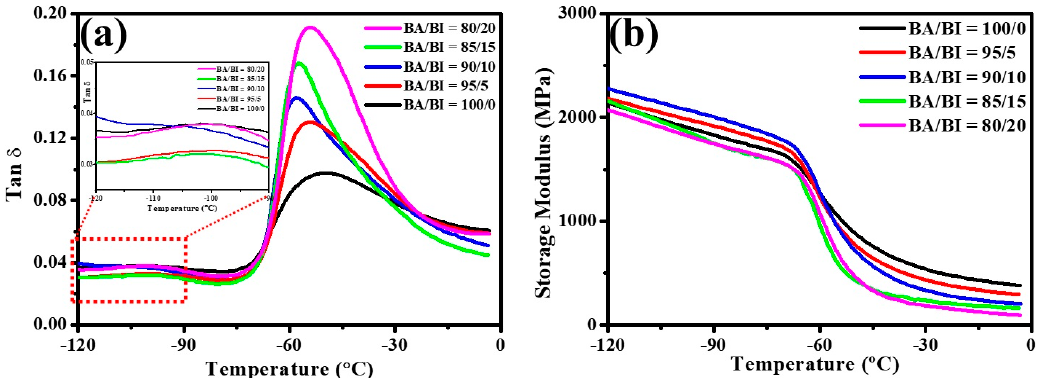
Figure 5. Dynamic mechanical analyzer (DMA) results for ( a ) Tan δ and ( b ) storage modulus of PBABI copolyesters.